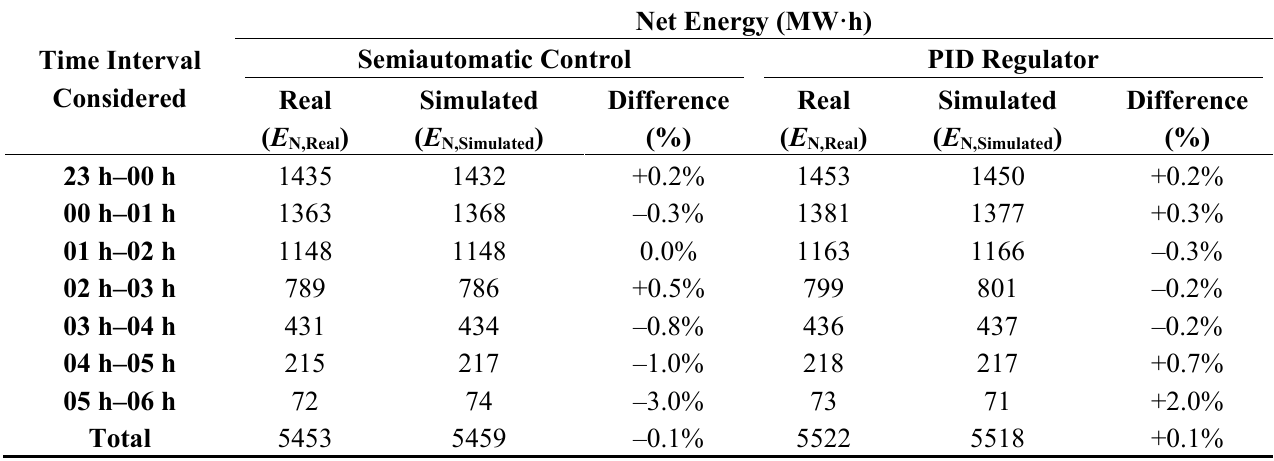
Table 12. Comparison of the net energy produced after 17